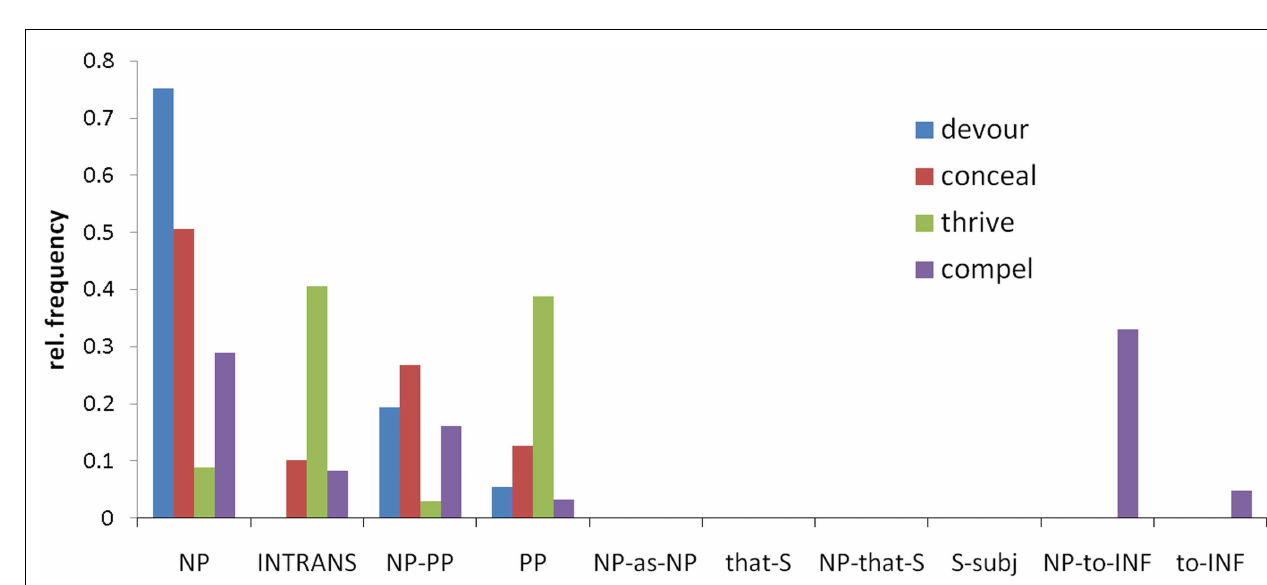
FIGURE 4 |The relative frequency distributions for four example verbs over the 10 most common subcategorization frames, which are labeled by a description of their argument structure . Different verbs have different distributions, illustrating the differences in their subcategorization frame